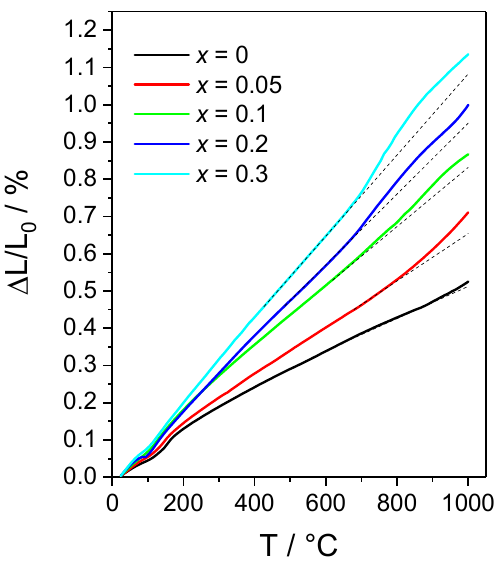
Figure 2. Heating curves of the series NAYZSiP x . Solid lines represent measured data that deviates from linear behavior (dotted line).